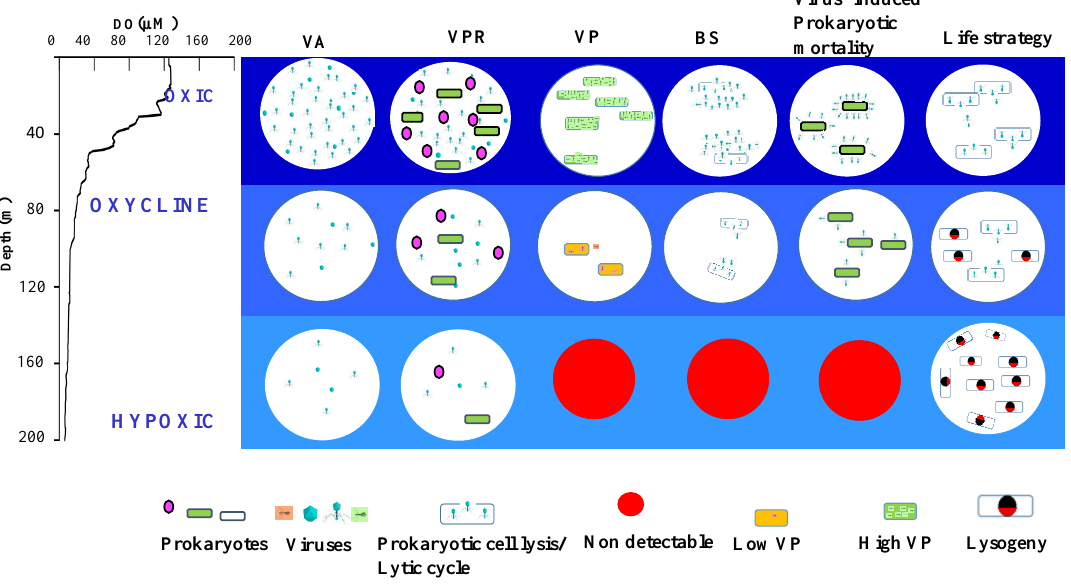
Figure 7. Conceptual diagram showing variations in viral parameters at different oxygen concentrations. The variations in viral parameters such as viral abundance (VA), virus to prokaryote ratio (VPR), viral production (VP), burst size, viral mediated prokaryotic mortality and reproductive life strategies at various vertical layers, oxic, oxycline, and hypoxic waters are